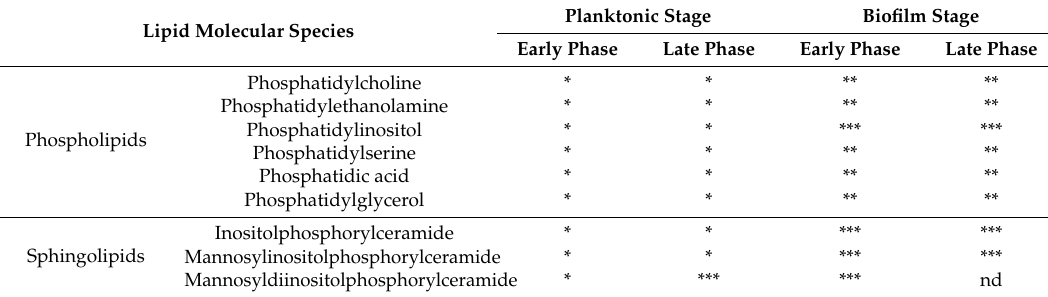
Figure 2. Cellular processes upregulated during biofilm formation at different time interval. Time course for upregulation of the listed cellular processed is shown as inferred from the transcriptome analysis reported by Yeater et al., 2007 [50]. Differentially regulated genes associated with lipid homeostasis during different phases of biofilm development are also shown. For simplicity, categories of genes upregulated at 6 h vs. 12 h are summarized under the 6 h heading whereas, data from the 12 h vs. 6 h and 12 h vs. 48 h comparisons are placed under 12 h heading. Individual genes upregulated at 48 h vs. 12 h are listed under 48 h section. Table 1. Distribution of lipids in C. albicans biofilms and planktonic cells as gathered from lipidomic analysis by Lattif et al. 2011 [52]. Asterisk (*) represents average lipid levels in biofilms and planktonic cells grown to early phase (6 h) or mature phase (48 h). The number of asterisks indicates the extent of alteration in the levels of the corresponding phospholipid in the given phase. The mean lipid levels were found to be increased in both early and late biofilm, compared to planktonic cells. nd: not